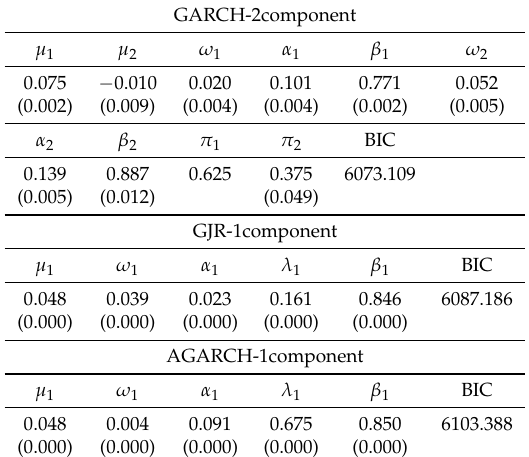
Table 5. Estimation of the Three Classes of GARCH(1,1) Families in JNJ.